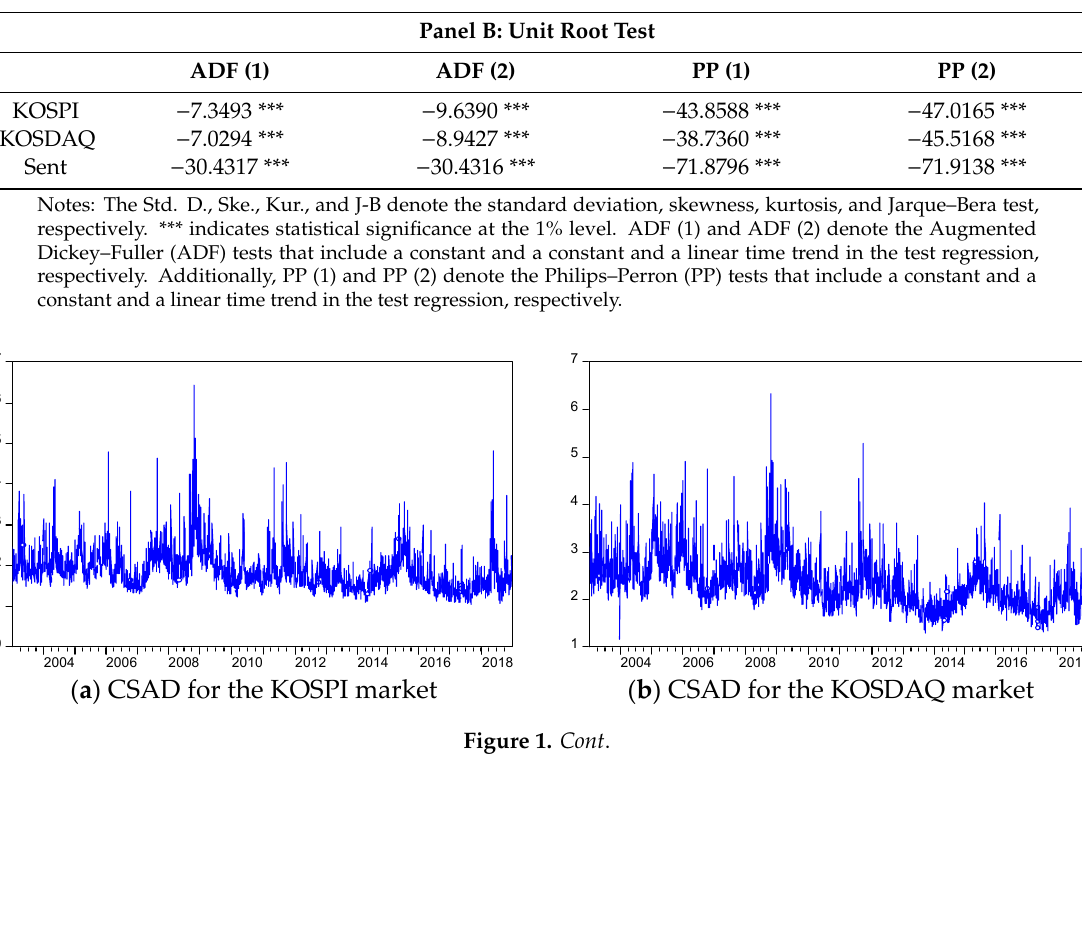
Figure 1. Dynamics of Cross-Sectional Absolute Deviation (CSAD) and Sent series: ( a ) CSAD for the KOSPI market; ( b ) CSAD for the KOSDAQ market; ( c ) Investor sentiment. Table 1. Descriptive statistics and unit root test of CSAD and Sent. Panel A: Descriptive Statistics